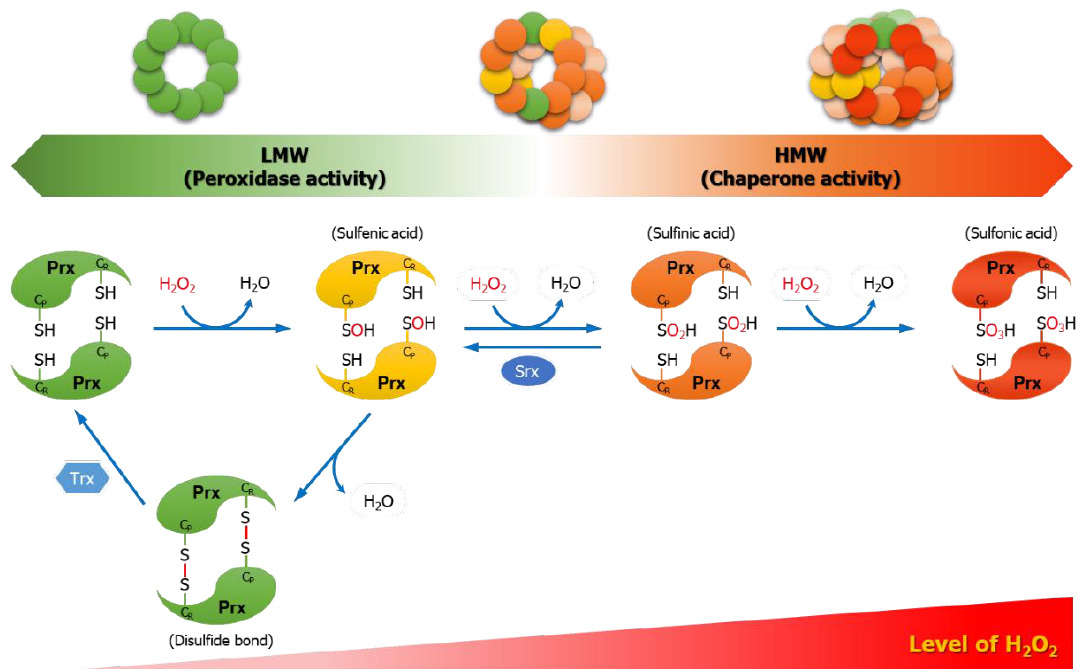
Figure 1. Catalytic cycle of typical 2-cysteine (Cys) Prxs. During the catalytic cycle of reducing